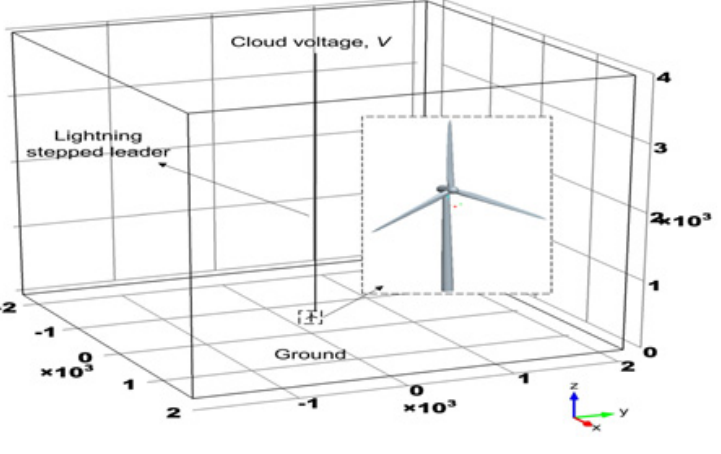
Figure 15. Problem setup in COMSOL Multiphysics [80].